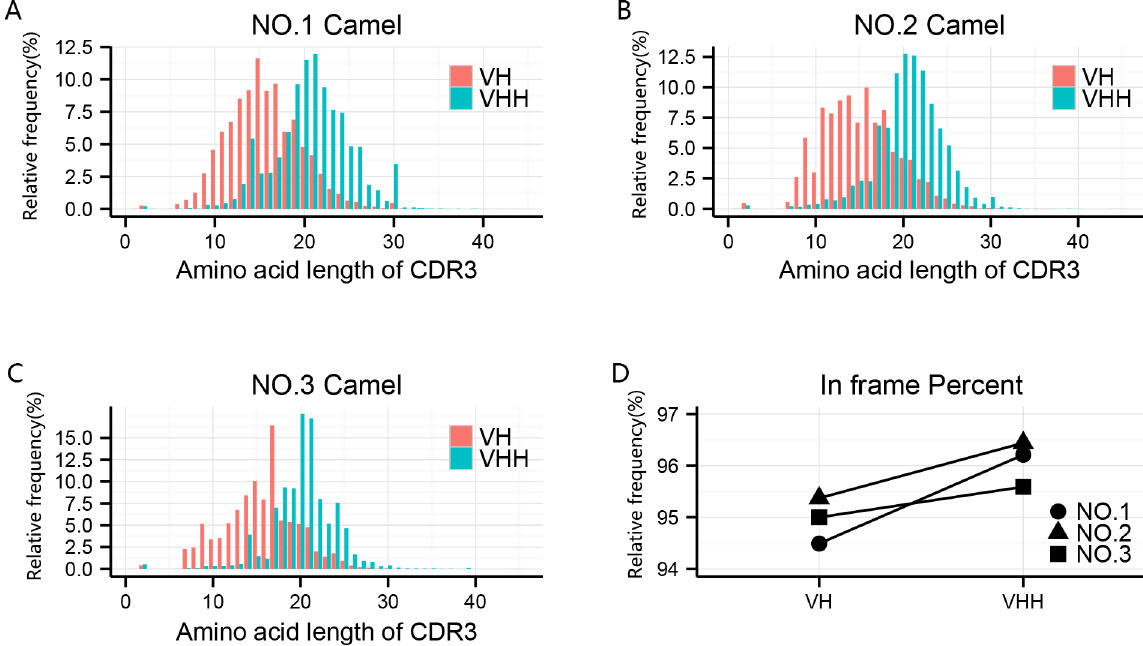
Fig 1. Schematic diagram of the CDR3 (AA)-relative analysis and in-frame percent (ORF) statistics. a-c The CDR3-related analysis of the NO.1, NO.2, and NO.3 camels including CDR3 length (AA) and proportion; d The comparison of in-frame percent of antibody variable region genes between VH and VHH clones of three camels.